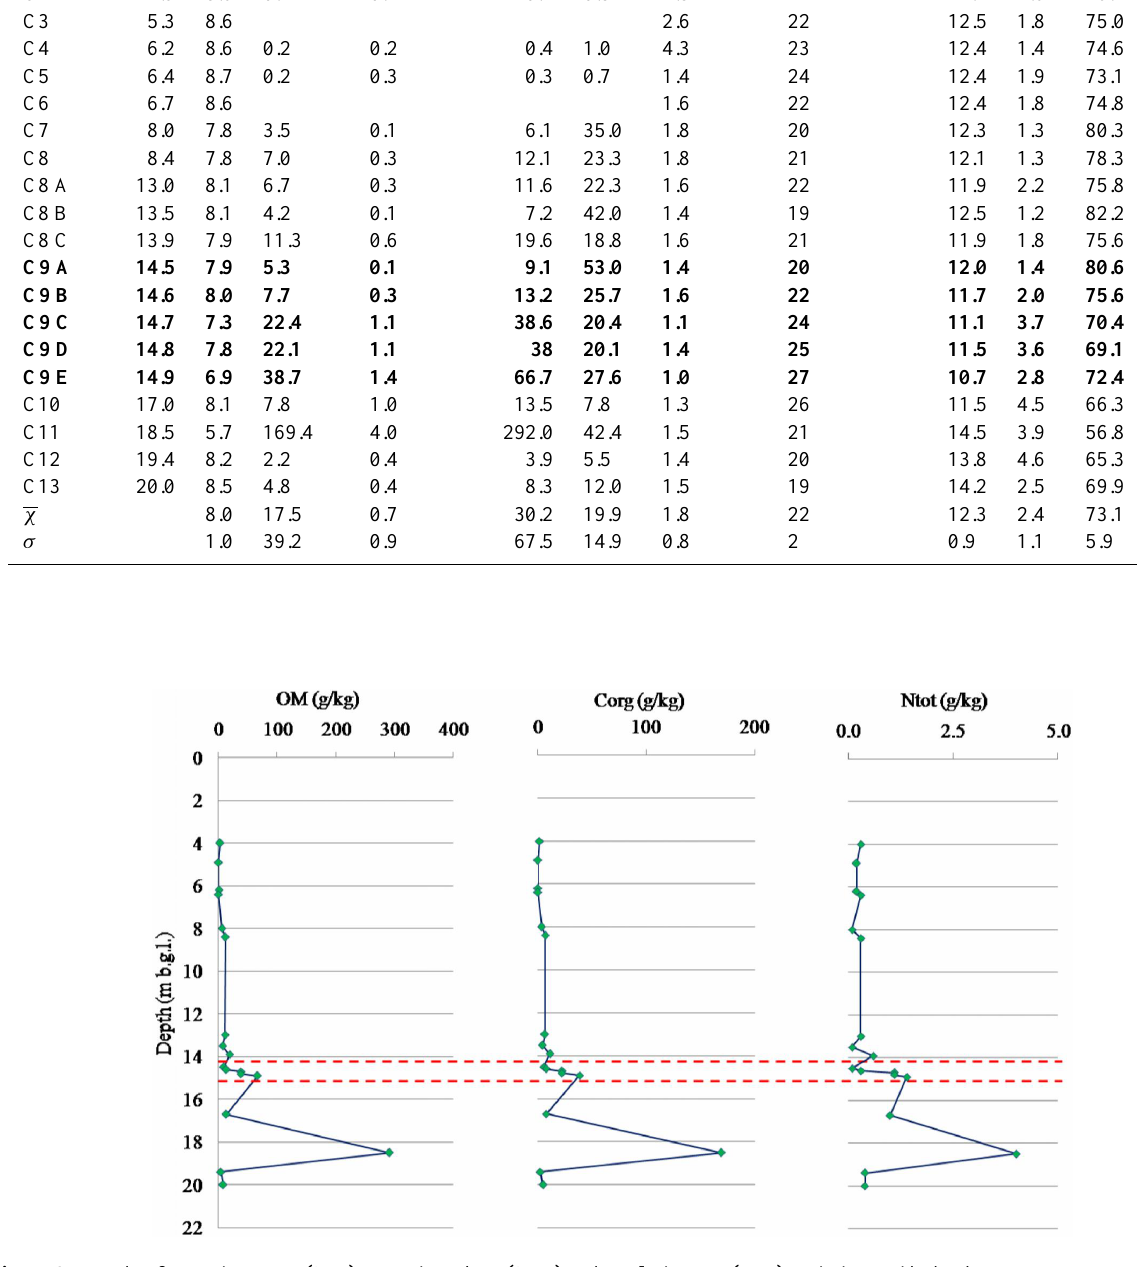
Figure 8. Trends of organic matter (OM), organic carbon (C org ) and total nitrogen (N tot ) variations with